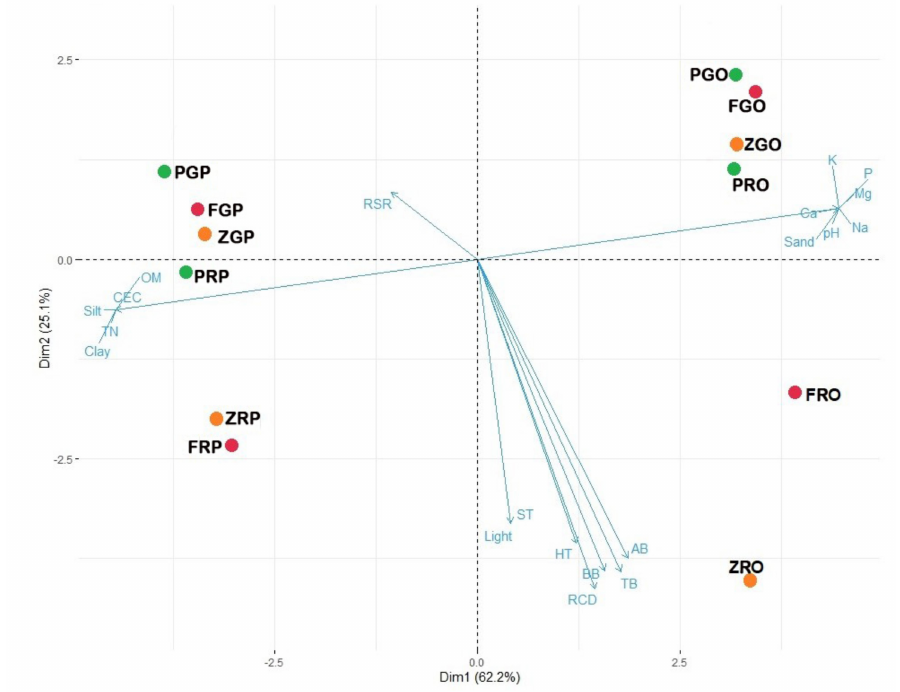
Figure 5. Principal-component-loading plot of the growth and site variables and individuals of Fraxinus rhynchophylla (FGP, FGO, FRO, FRP), Pinus koraiensis (PRP, PGP, PRO, PGO) and